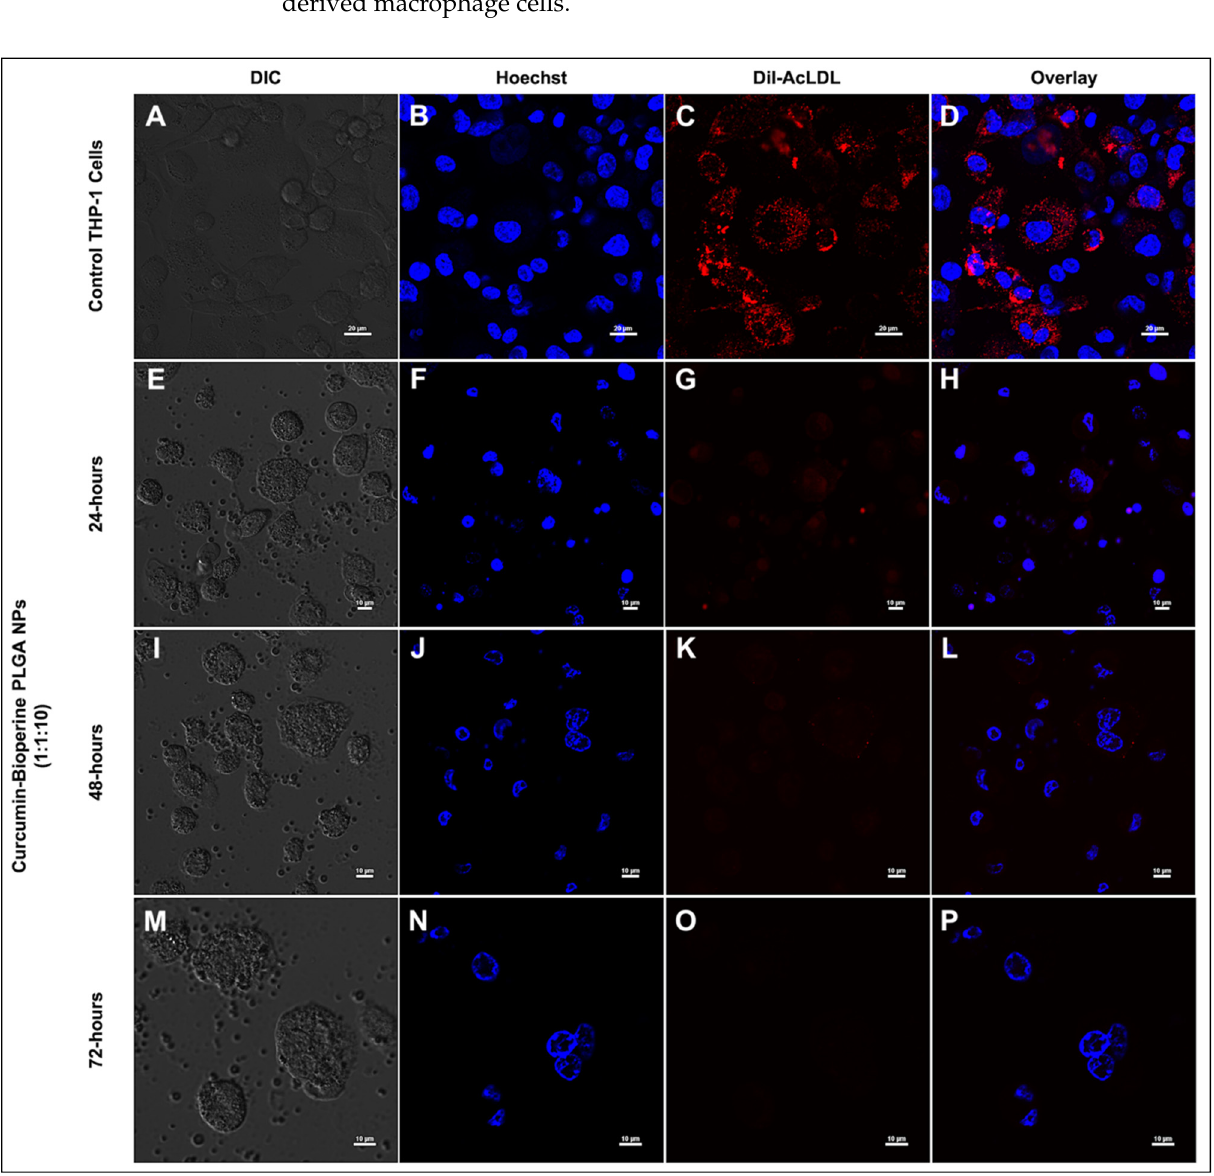
Figure 7. Confocal laser scanning microscopy analysis shows the Dil-AcLDL staining on THP-1 monocyte-derived macrophage cells to check the inhibition of foam cell formation. THP-1 monocyte-derived macrophage cells were pre-treated with curcumin-Bioperine PLGA NPs (1:1:10) for 24–72 h, followed by incubation of Dil-AcLDL for 4 h. The top panel ( A – D ) shows the control THP-1 monocyte-derived macrophage cells forming foam cells (Scale bar 20 μ m). The second panel ( E – H ), third panel ( I – L ), and fourth panel ( M – P ) show the inhibition of foam cell formation upon treated with curcumin-Bioperine PLGA NPs 1:1:10 for 24–72 h (scale bar 10 µ